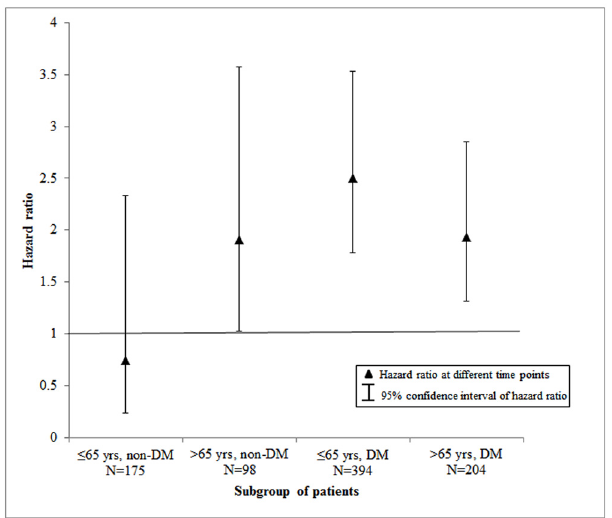
Fig 3. Hazard ratio for risk of death during 5-year follow-up for patients initiating PD compared with those initiating HD and 95% confidence intervals, stratified by age and the presence of DM.